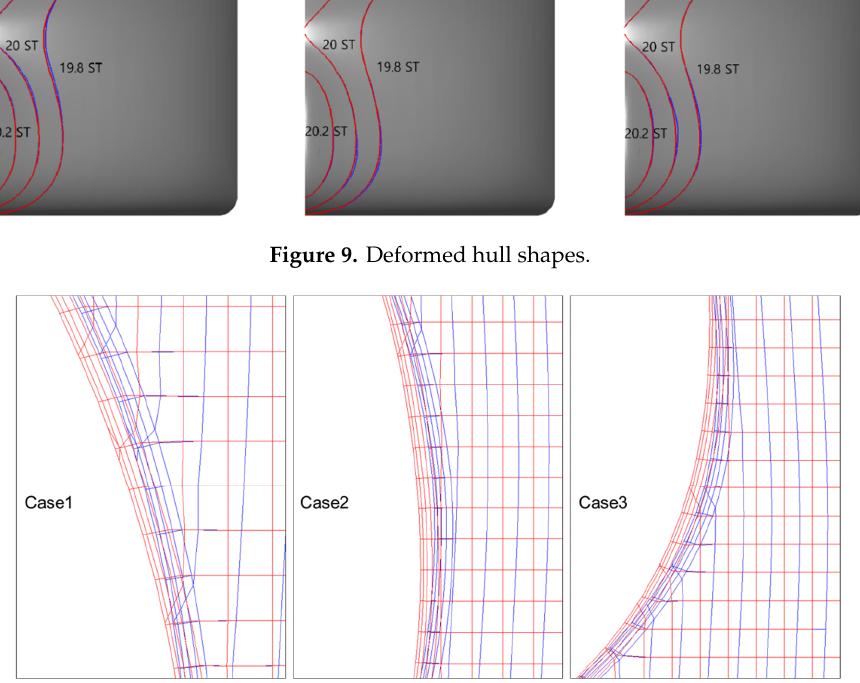
Figure 10. A slice of the deformed mesh at forward perpendicular (F.P.) (red grid line: original mesh, blue grid line: deformed mesh).